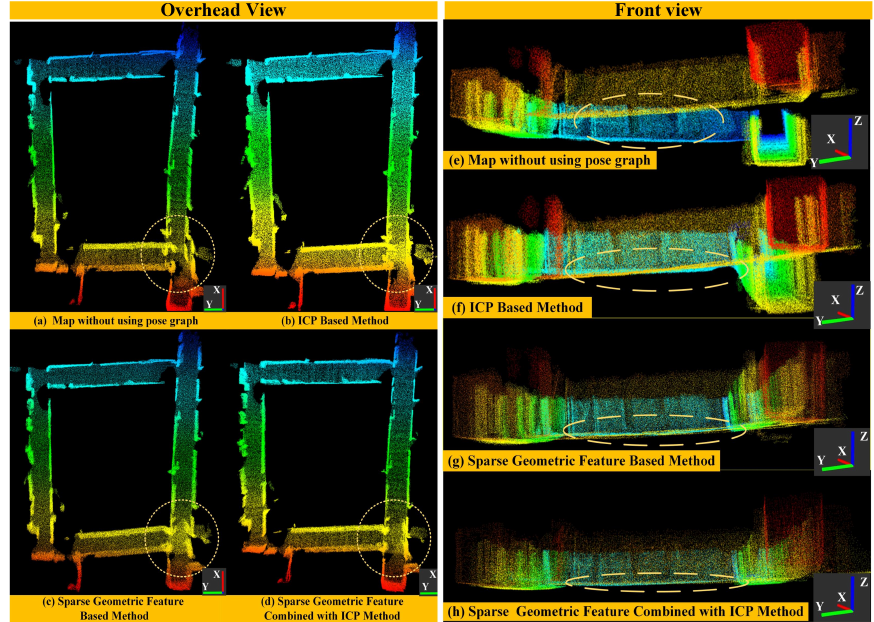
Figure 10. The accuracy comparison of mapping results after applying different kinds of methods for loop detection in the overhead and front view (the yellow dashed circle denotes the main difference in the global